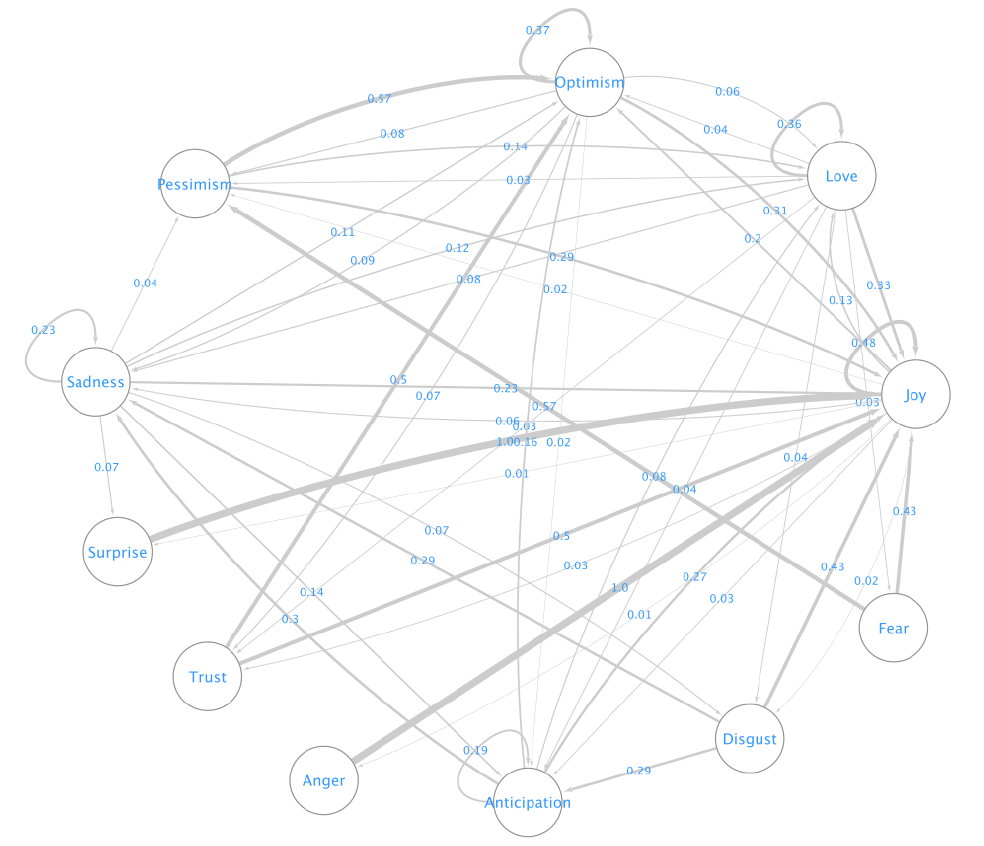
Figure 7. Emotion transition graph of users during the study